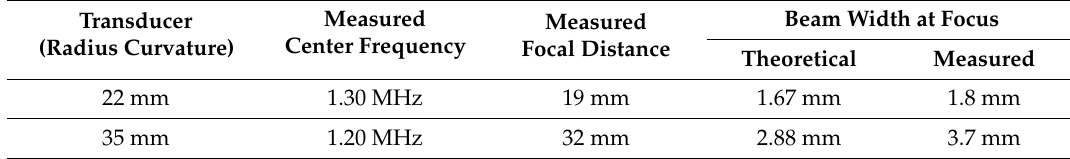
Table 4. Focal distance and beam width at